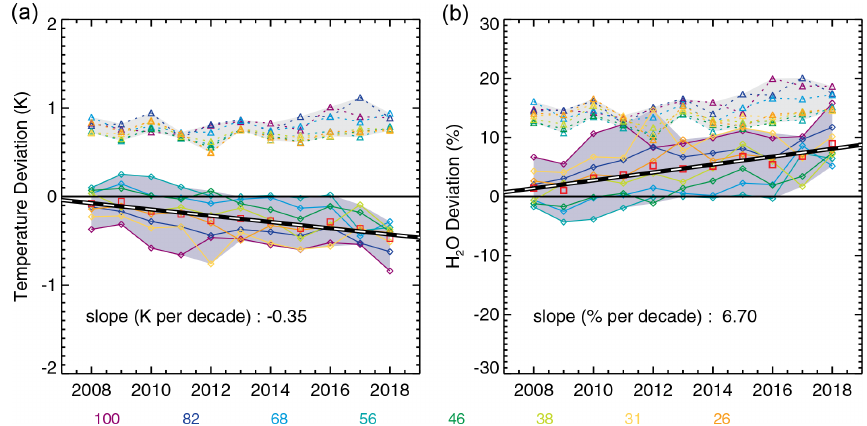
Figure 5. (a) MLS H 2 O is used to calculate the water-ice frost point (in the presence of CALIOP ice PSCs) for observations south of 60 ◦ S, between 100 and 26hPa and days 140 and 230 of each year. The annually and spatially averaged difference between the interpolated ERA-I temperature and the MLS-calculated frost point is shown by the solid lines with diamonds. Colors indicate the MLS pressure levels (hPa; see legend). Shading encompasses the range of deviations for all pressure levels considered, and the red squares are the means over all pressure levels. Triangles connected with dotted lines show the standard deviations of the individual differences (with shading again indicating the range of these values). Panel (b) shows the equivalent differences and standard deviations if the ERA-I temperatures are taken to be unbiased and stable and the same microphysical calculations are instead used to provide an estimate of water vapor. This is then compared to MLS water vapor observations (MLS minus estimates from